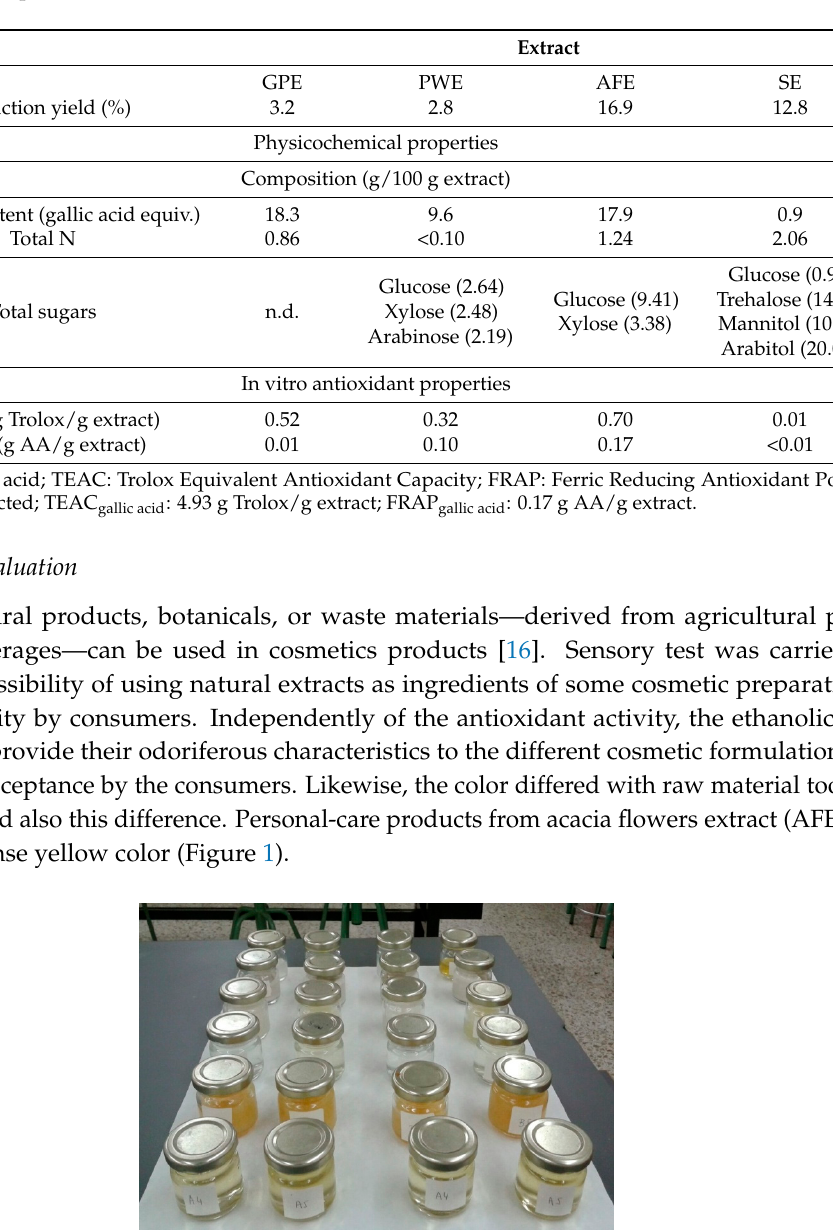
Table 1. Characterization of extracts obtained from renewable underutilized sources: grape pomace extract (GPE), pine wood extract (PWE), acacia flower extracts (AFE), and shiitake extract (SE).